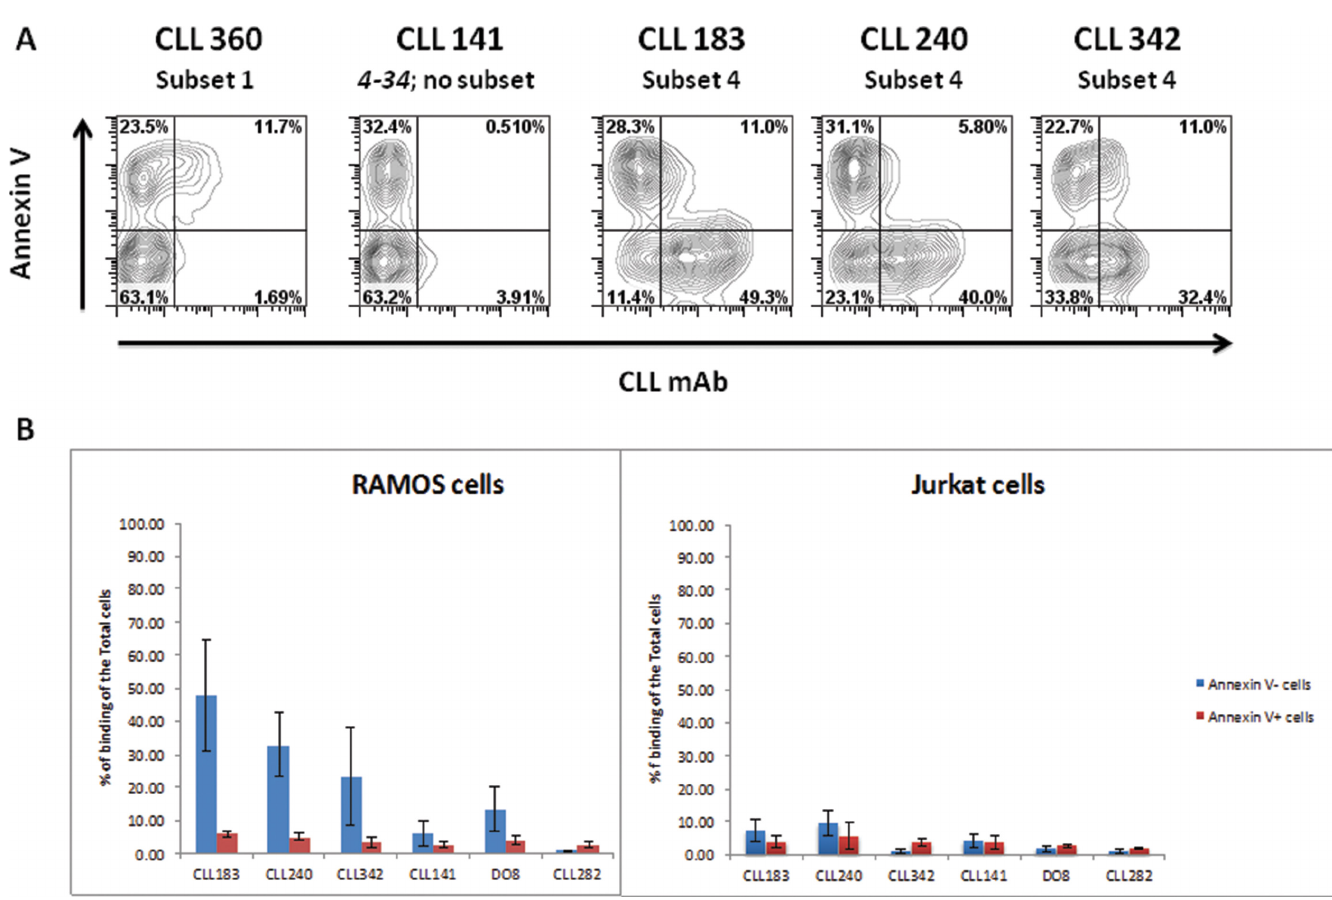
Figure 1. Subset 4 IGs bind to viable human B lymphocytes. Subset 4 mAbs (nos. 183, 240, 342) were incubated with Ramos or Jurkat cell line cells under nonpermeabilizing conditions. mAb141, which expresses IGHV4-34 but does not belong to subset 4, and mAb360, which is a member of subset 1 and does not express IGHV4-34 , were used as comparators. Apoptosis was measured by annexin V staining. (A) Representative contour plots of CLL mAb binding to Ramos cells. Binding detected by FITC-labeled F(ab’)2 fragments of goat poly- clonal antibodies (pAbs) specific for human IgG. (B) Average binding of live (annexin V – ) and apoptotic/dead (annexin V + ) Ramos and Jurkat cells by the following biotinylated CLL mAbs: subset 4 mAbs183, 240 and 342; non–subset 4 IGHV4-34 –expressing CLL mAbs 141 and DO8; and subset 2 mAb282 ( IGHV3-21/IGLV3-21 ). Binding was detected by streptavidin PE-Cy7. Data obtained from four indepen- dent experiments. Error bars represent